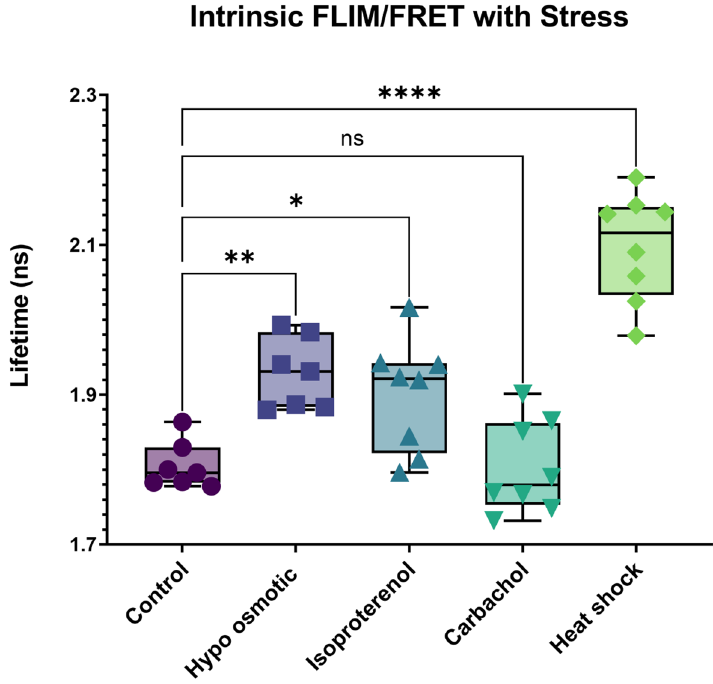
Figure 4. Intrinsic FLIM measurements to evaluate mitochondrial health. Untransfected, differentiated PC12 cells were exposed to carbachol, osmotic stress and heat shock before imaging at 740 nm excitation using a two photon laser, and measuring the autofluorescence lifetime by phase-modulation where n = 8. P values were calculated using one-way ANOVA analysis comparing the specific sample with control. * = p ≤ 0.05, ** = p ≤ 0.01, *** = p ≤ 0.001, **** = p ≤